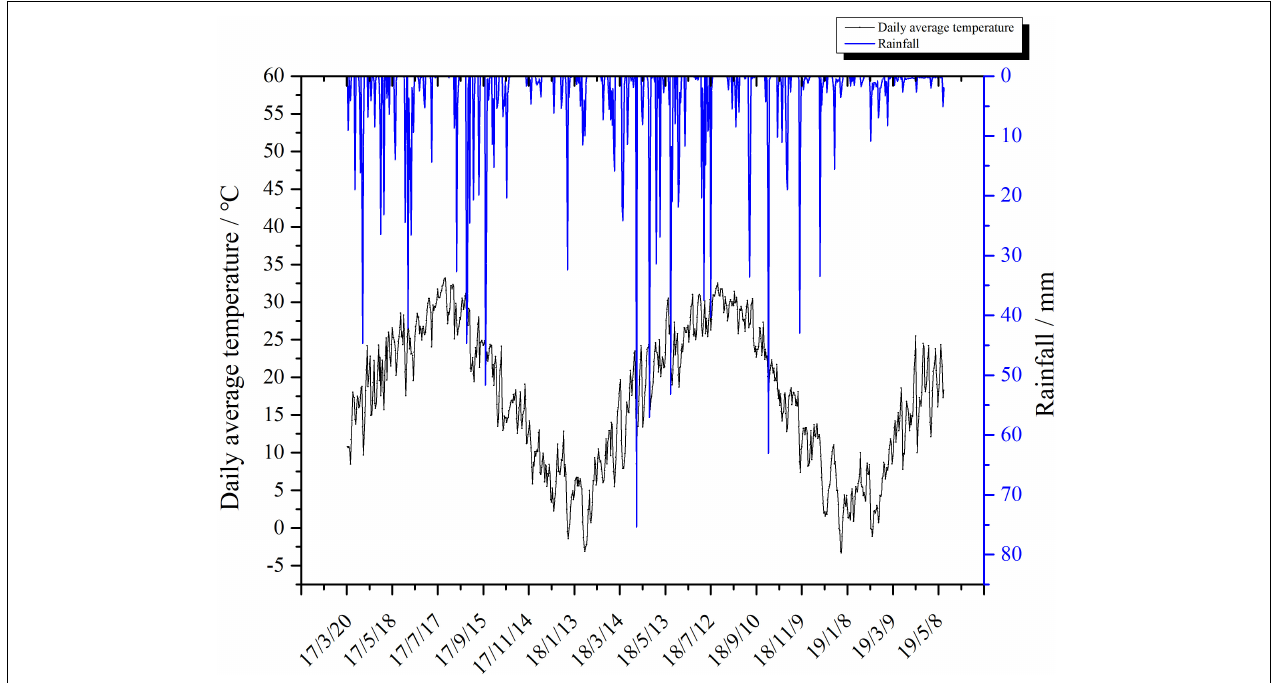
FIGURE 1 | Local daily average temperature and rainfall during the test